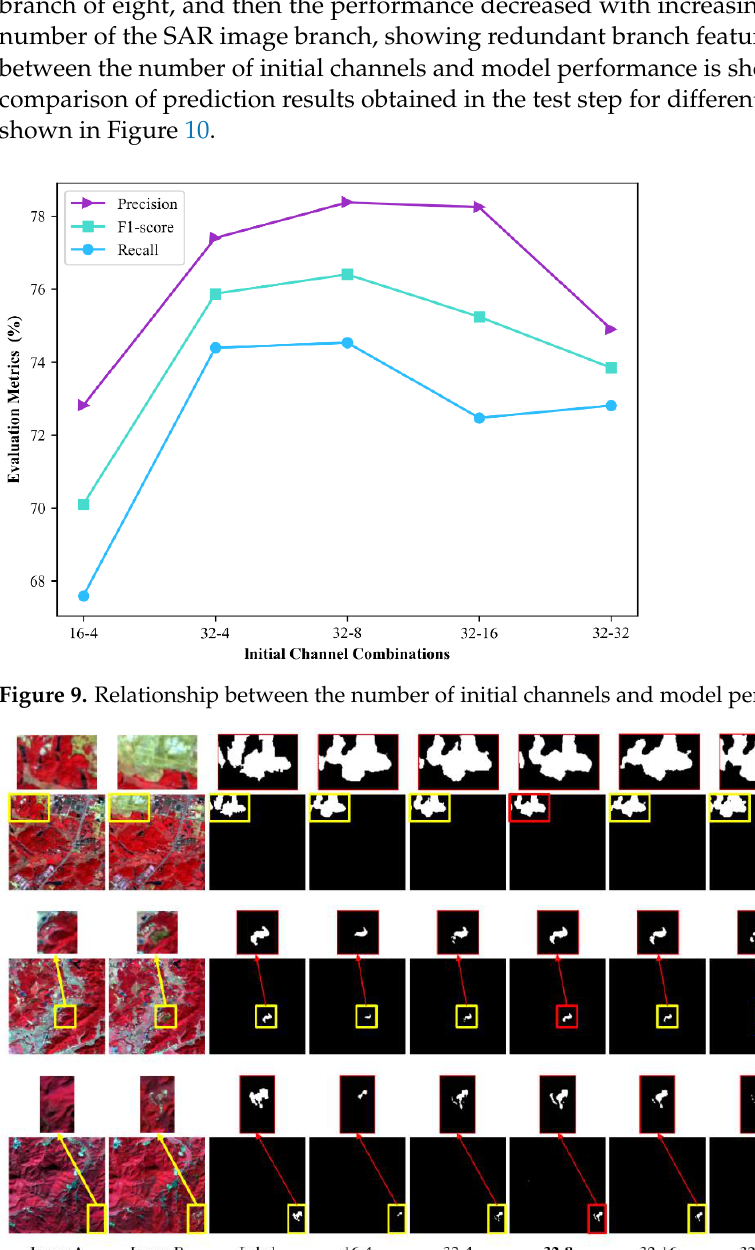
Figure 10. The results on the test step for different combinations of channel